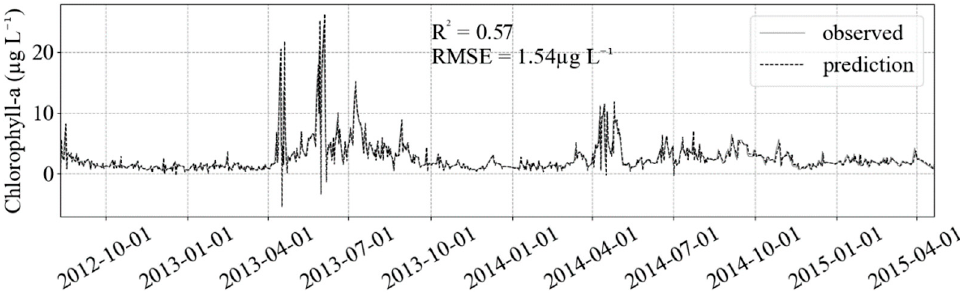
Figure 7. Result of SARIMA fit (black dashed) in the test dataset (gray solid). The better fit in extreme values is counter-balanced by the estimation of negative values, decreasing/increasing R 2 /RMSE compared to the ML models results.